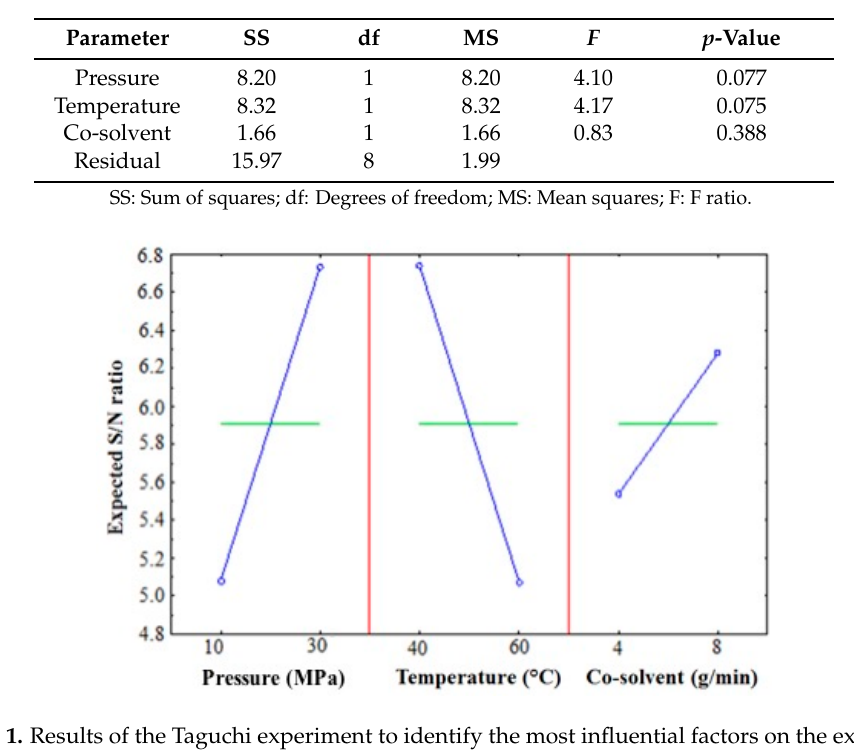
Table 2. Analysis of variance of the different treatments of Mexican arnica extracted with supercritical CO 2 .